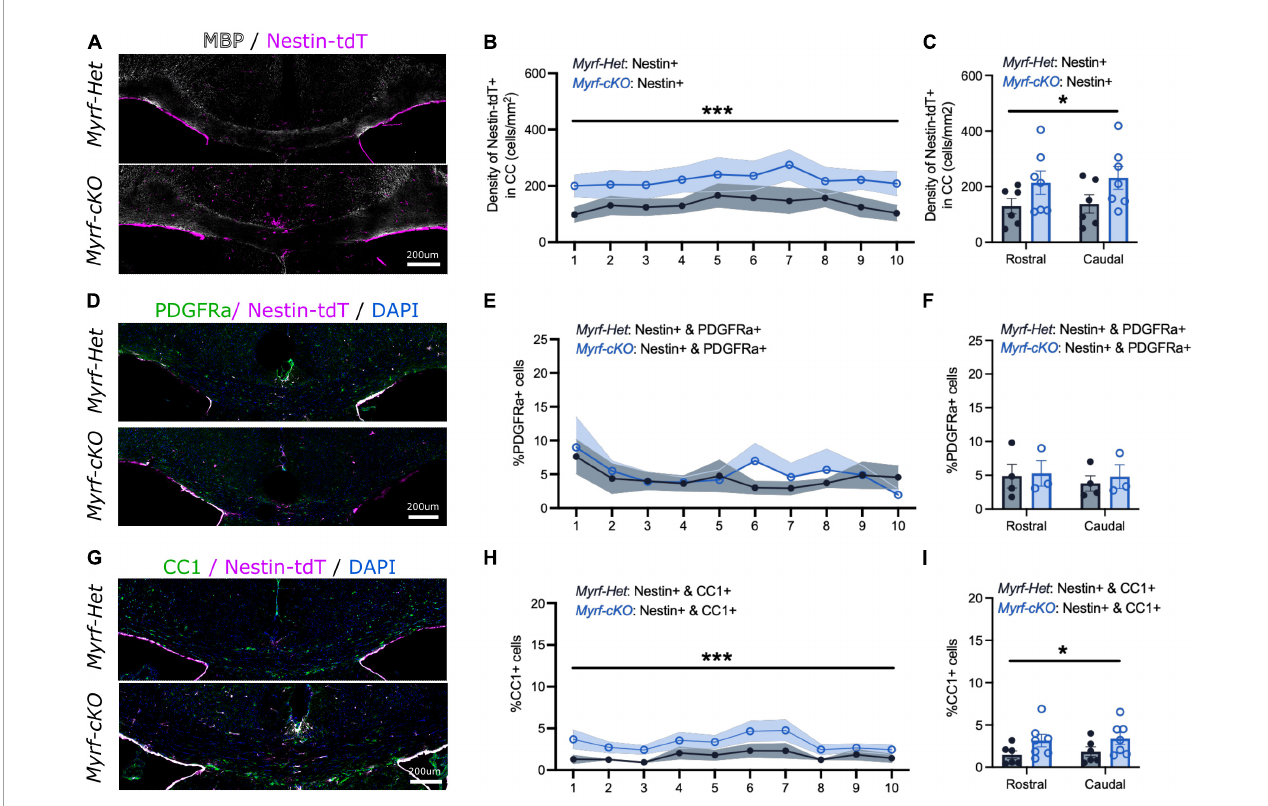
FIGURE3 The contribution of neural stem cell-derived oligodendrocytes (OLs) to remyelination increases at 2 weeks of recovery when parenchymal oligodendrocyte progenitor cell differentiation is blocked. (A) Representative images of Myrf-Het;Nestin-tdT and Myrf-cKO;Nestin-tdT coronal brain sections immunostained for MBP (in white) and Nestin-tdT (magenta) after 2-week recovery (Cup6w + 2w). (B) Quantification of the densities of Nestin-tdT+ cells within the CC of Myrf-Het;Nestin-tdT and Myrf-cKO;Nestin-tdT coronal sections ( n = 6–7, lines and shading represent mean ± sem, *** p < 0.001, Two-way ANOVA). (C) Average densities of Nestin-tdT+ cells within the CC of Myrf-Het;Nestin-tdT and Myrf-cKO;Nestin-tdT rostral (sections 1–5) and caudal (sections 6–10) sections ( n = 6–7, error bars = sem, * p < 0.05, Two-way ANOVA). (D) Representative images